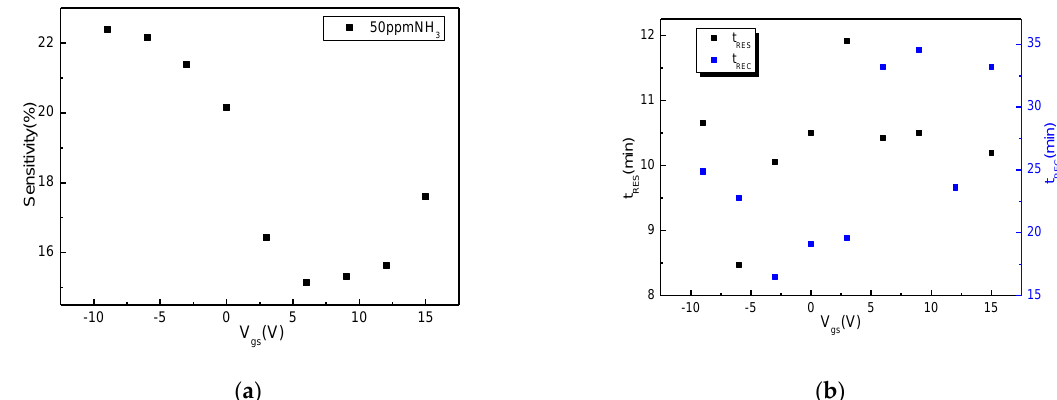
Figure 7. Linearity fitting curves of 1- and 9-min samples.